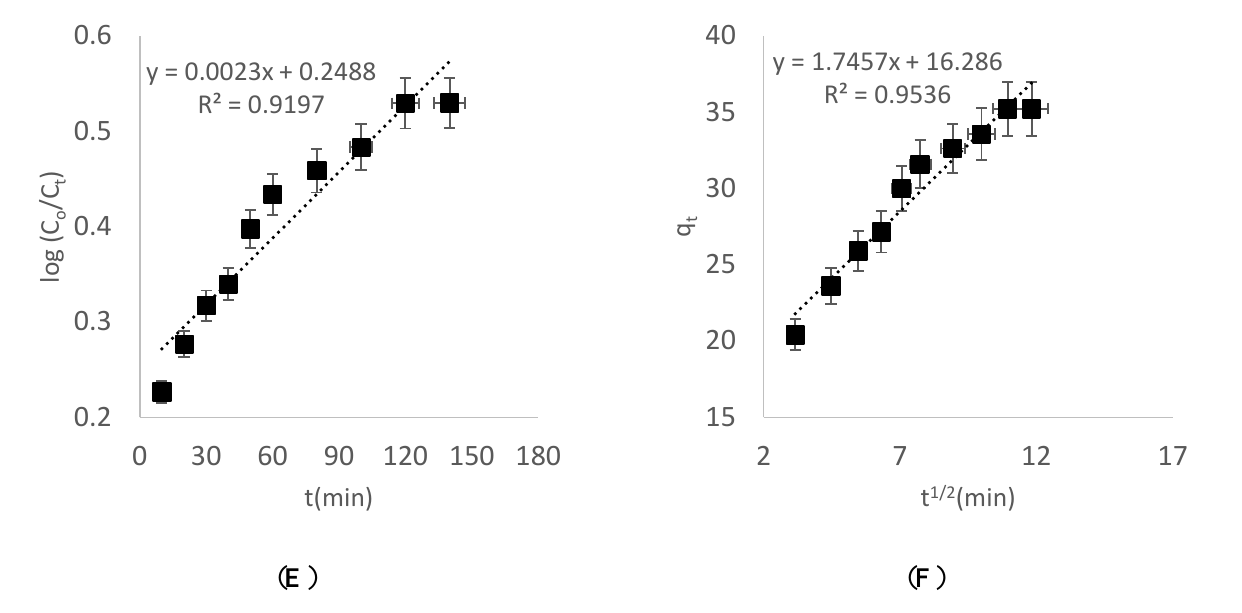
Figure 3. Kinetic aspect of the process: ( A ) impact of contact time, ( B ) pseudo first order kinetic graph, ( C ) pseudo second order kinetic graph, ( D ) power function kinetic plot, ( E ) Natarajan – Khalaf kinetic plot, ( F ) intra particle kinetic plot.